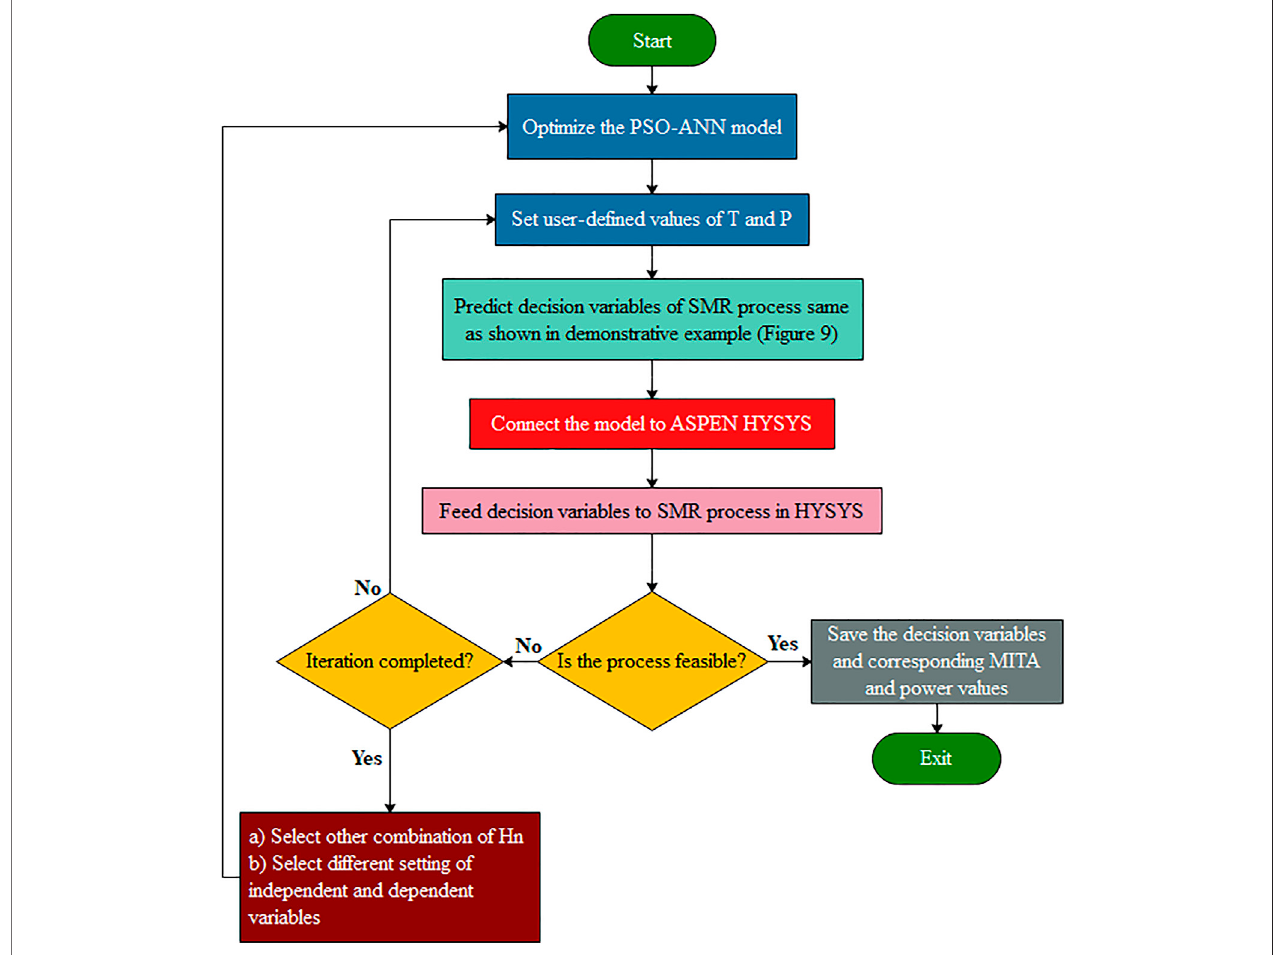
FIGURE 8 | Framework of the proposed PSO-ANN model for the SMR process.